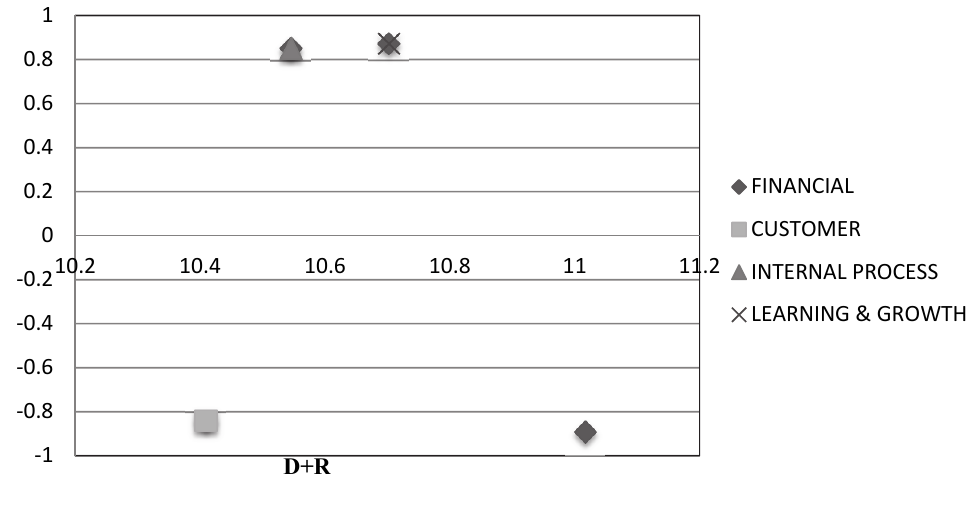
Fig. 3. Causal diagram of the